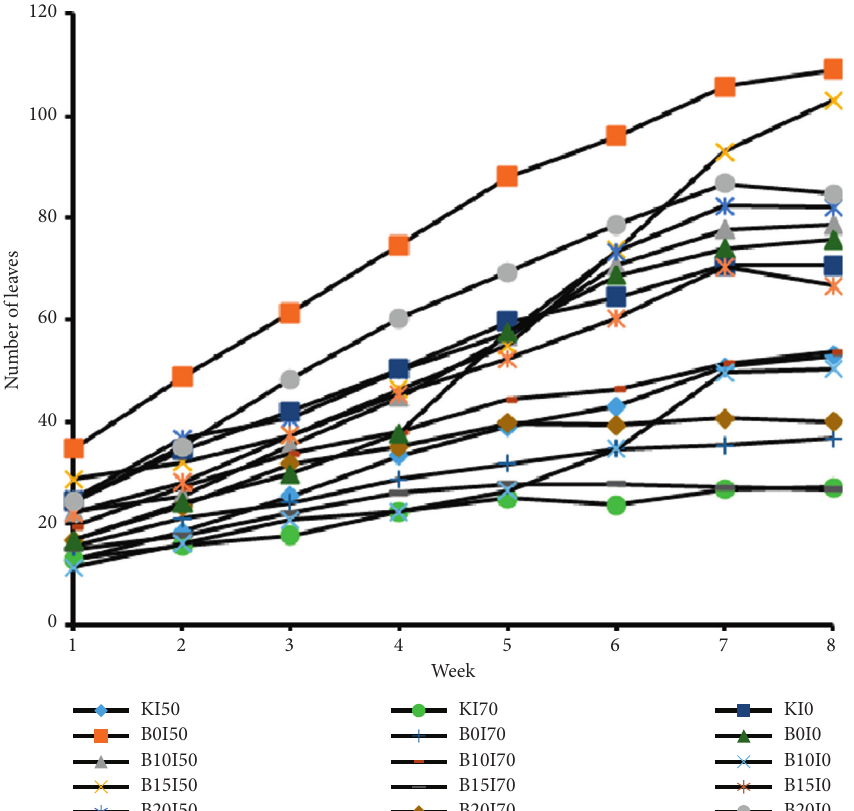
Figure 2: Number of leaves of longevity spinach ( Gynura procumbens ) plants as affected by biochar and shade